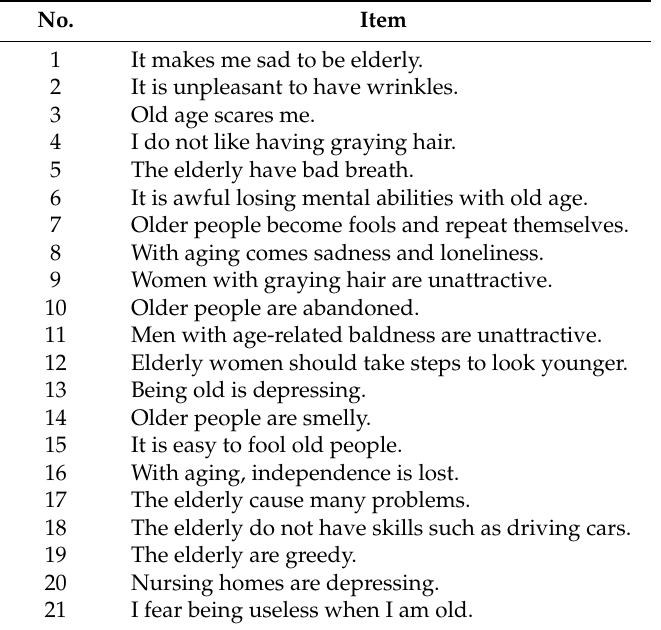
Table 1. Self-perception scale of old